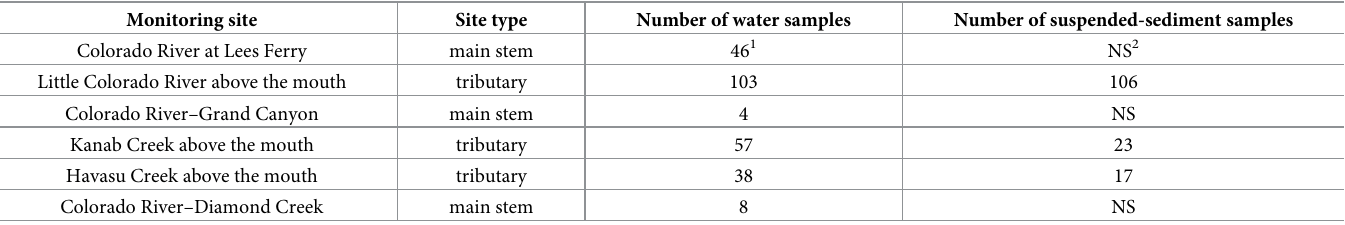
Table 3. Number of water and suspended sediment samples collected at each monitoring site during the 2015–2018 time period of this study, in downstream